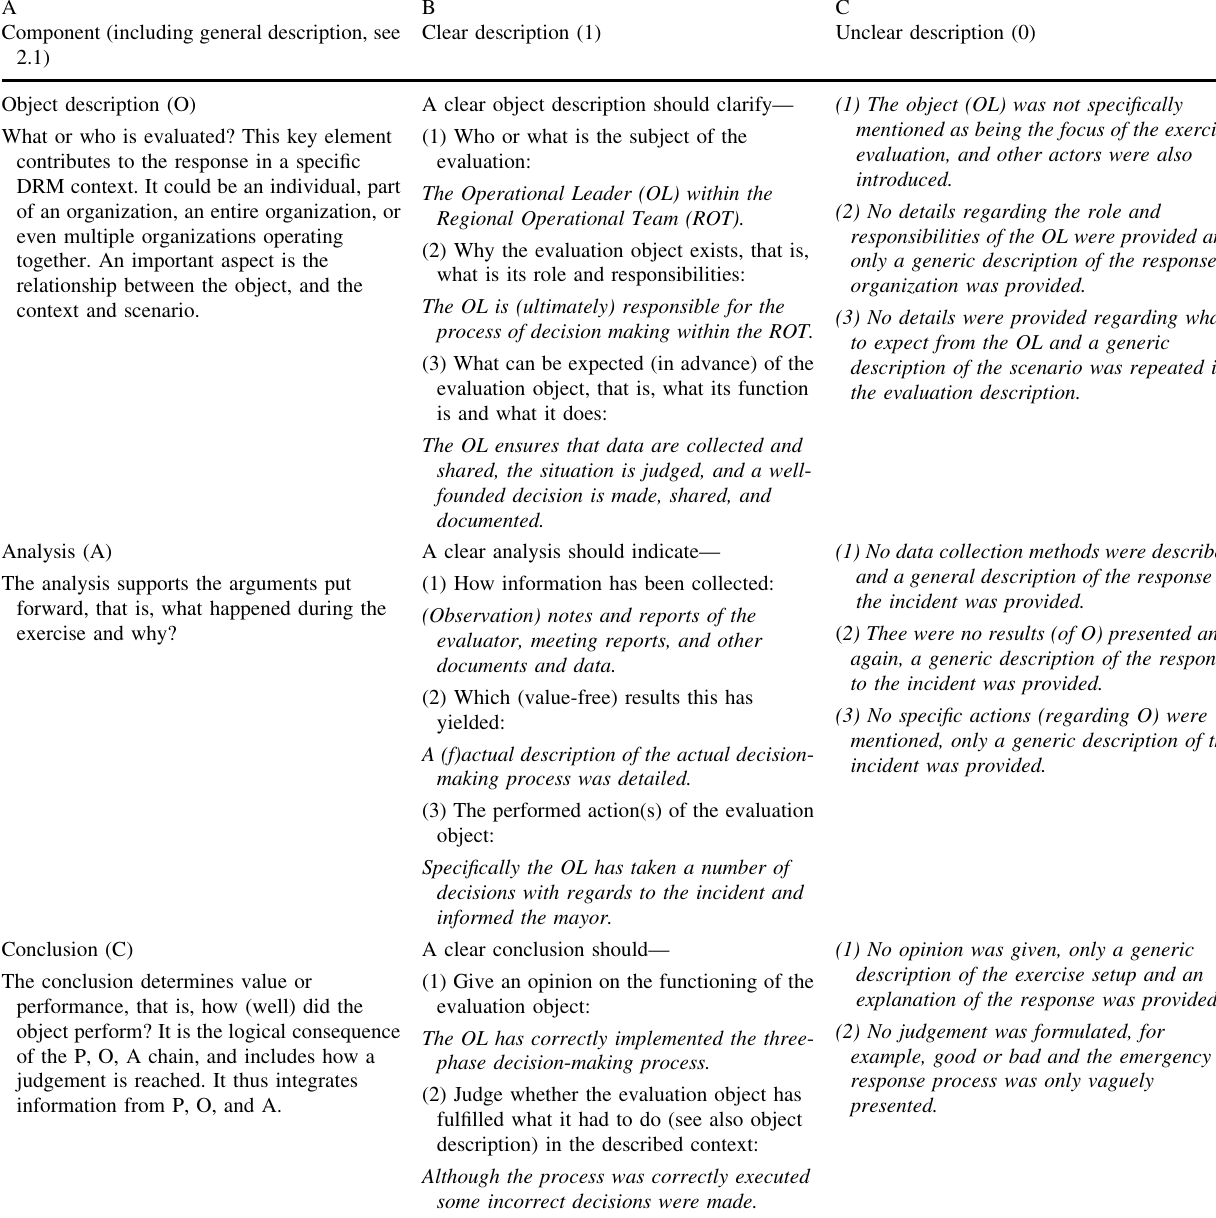
B Clear description (1)